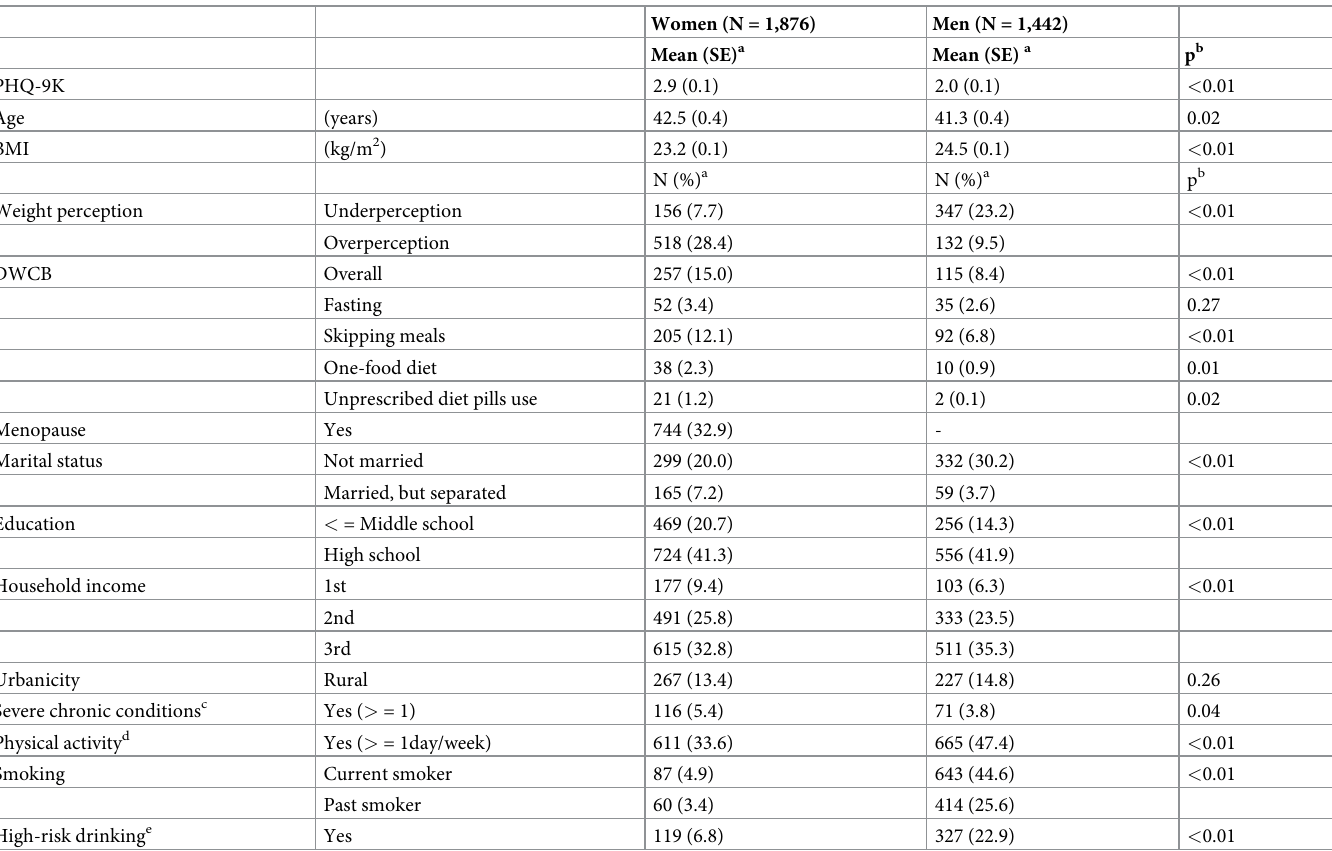
Table 1. Descriptive characteristics of the study sample (N = 3,318): Korean adults aged 19–65 years with BMI > = 18.5kg/m 2 and no history of